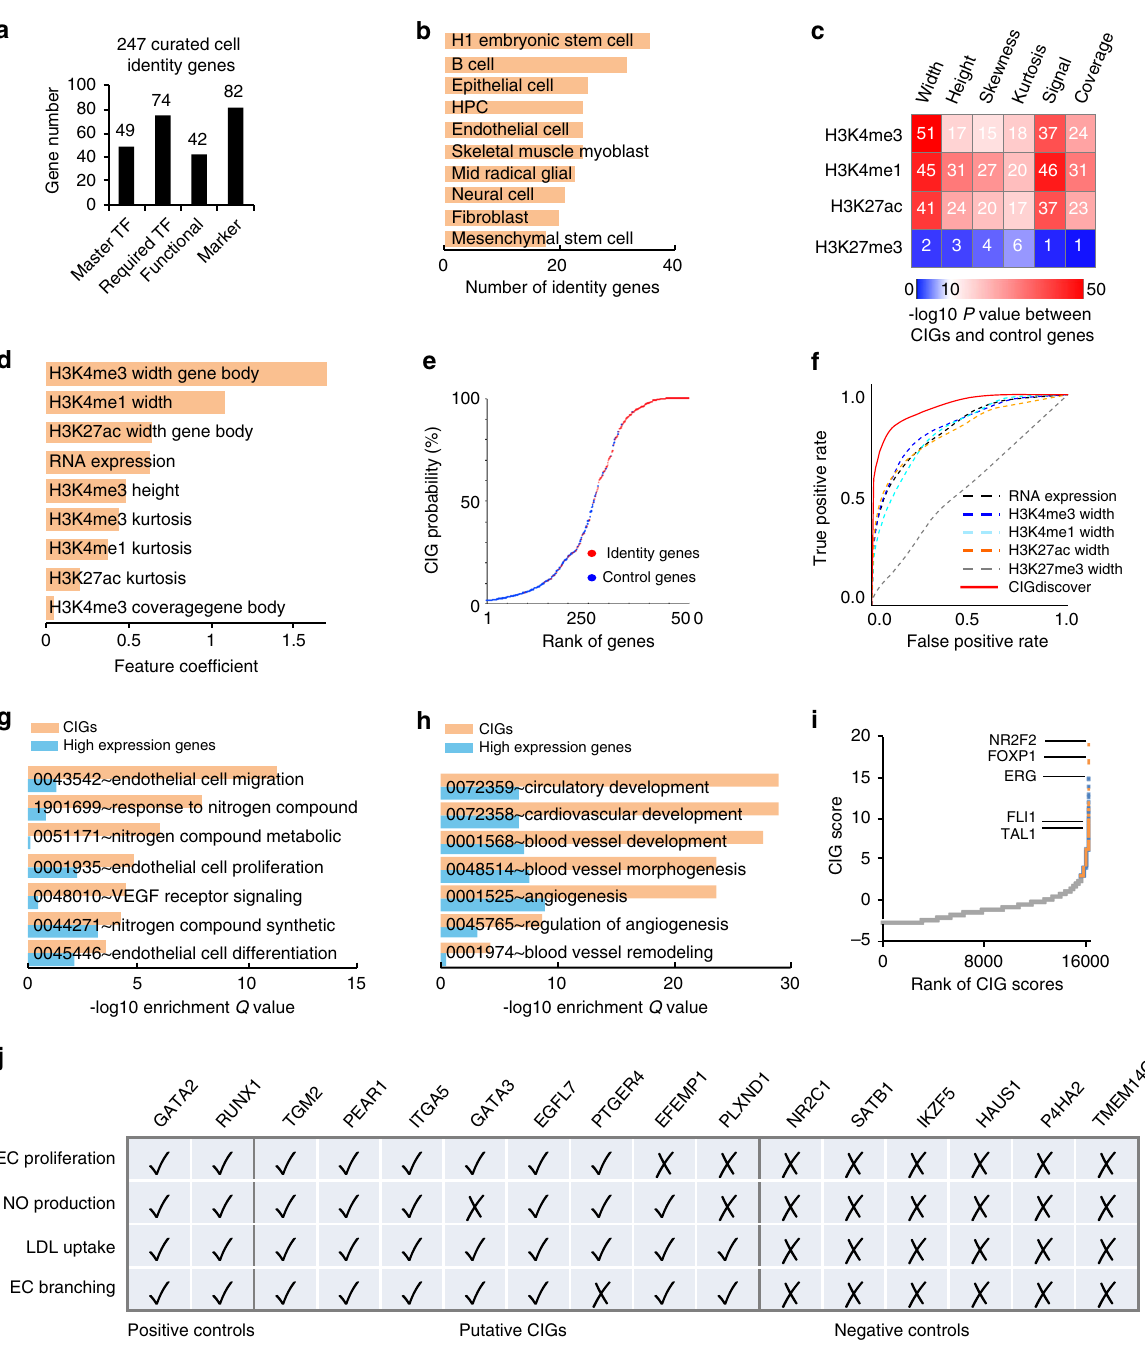
Fig. 1 CIGdiscover uncovers cell identity genes (CIGs) on the basis of the unique histone codes for their transcriptional regulation. a , b The number of curated CIGs for each category ( a ) or cell type ( b ). c Heatmap to show − log10 P -value for difference in histone modi fi cation feature between CIGs and random control genes. P -values determined by Wilcoxon test. d Bar plots to show importance, as determined by coef fi cient, for each individual feature used by the logistic regression model in CIGdiscover. e The probability calculated by CIGdiscover to be CIG plotted for each curated known CIG and control gene. f ROC curves to show accuracy for CIG prediction using CIGdiscover or other methods. g , h Barplot to show enrichment of endothelial ( g ) or cardiovascular ( h ) related pathways in CIGs uncovered by CIGdiscover or in high expression genes for HUVECs. i Endothelial CIG score determined by CIGdiscover for each gene. Predicted EC CIGs that were found to have reported endothelial functions are marked in orange color. Predicted EC CIGs that were not found to have reported endothelial functions are marked in blue color. Genes not predicted to be EC CIGs are in gray color. j Summary of experiment veri fi cation results for predicted CIGs, positive control genes, and negative control